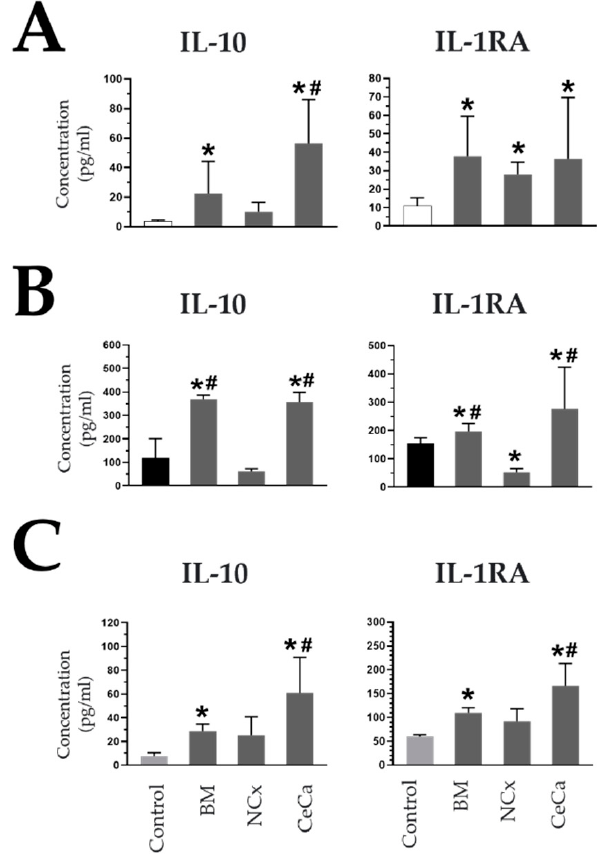
Figure 6. CeCa-MSCs, unlike NCx-MSCs, in coculture with macrophages increase the concentration of soluble anti-inflammatory molecules. ( A ) Evaluation of the concentration (pg/mL) of soluble molecules in cocultures of MSCs with macrophages in the absence of inducer medium (M0). ( B ) Evaluation of the concentration (pg/mL) of soluble molecules in cocultures of MSCs with macrophages in the presence of M1 inducer medium (M1). ( C ) Evaluation of the concentration (pg/mL) of soluble molecules in cocultures of MSCs with macrophages in the presence of M2 inducer medium (M2). Bar graphs represent the mean and standard deviation. * Significant difference from the control, # significant difference from NCx-MSCs ( p < 0.05); n = 6.